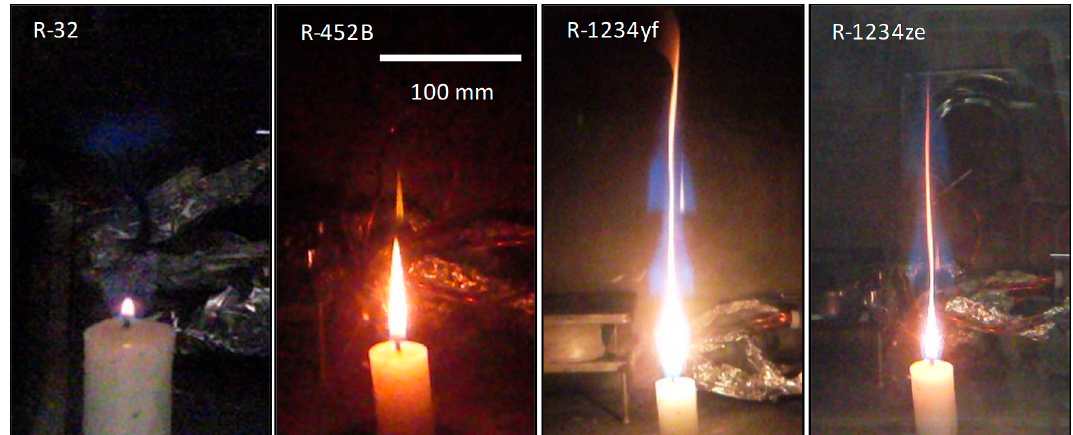
Figure 5. Images from candle tests corresponding to the largest flame for each test. A video of these tests is provided in the Supplementary Materials Video S5.